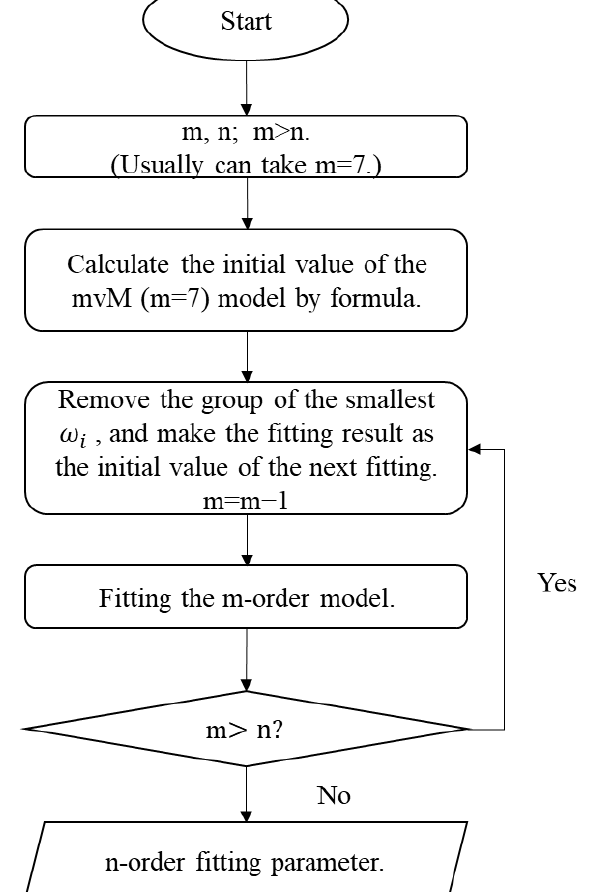
Figure 5. Flow chart of parameter determination of mvM model.